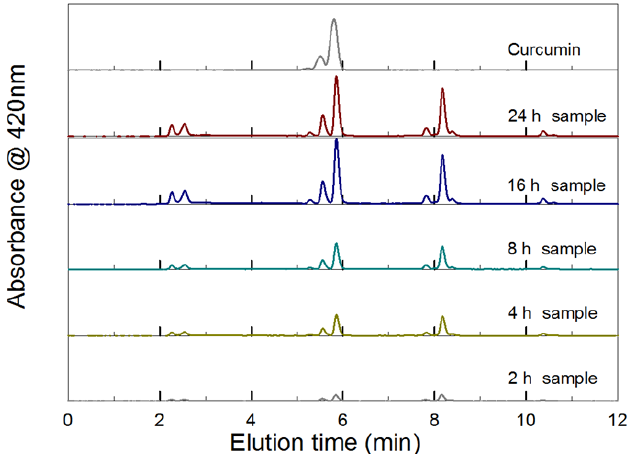
Figure 3. HPLC peak elution profile (420 nm) for supernatant samples collected during aqueous dissolution of the PCBAE prodrug tablet.